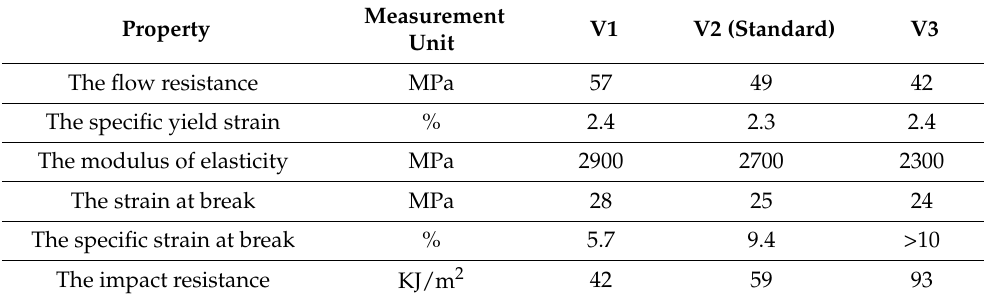
Table 1. Comparative characteristics of Arboblend